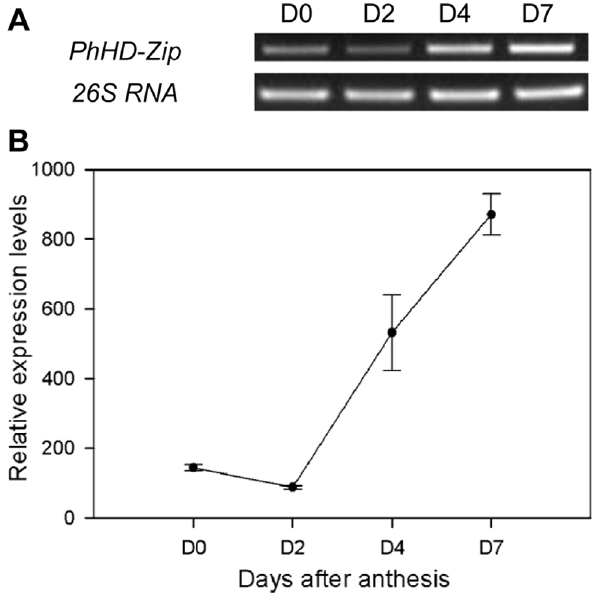
Figure 1. Expression of PhHD-Zip in petunia corollas during flower senescence. A. A representative gel image from semi- quantitative PCR of RNA isolated from corollas harvested at intervals after anthesis. D0: at anthesis; D2, D4, D7: 2, 4, and 7 days after anthesis, respectively. 26S RNA: the internal control. Samples were analyzed after 30 cycles of amplification for PhHD-Zip , and after 24 cycles of amplification for 26S RNA . B. Relative expression levels of PhHD-Zip (quantification of the gel pictures; error bars show SE of the means of three biological replicates).